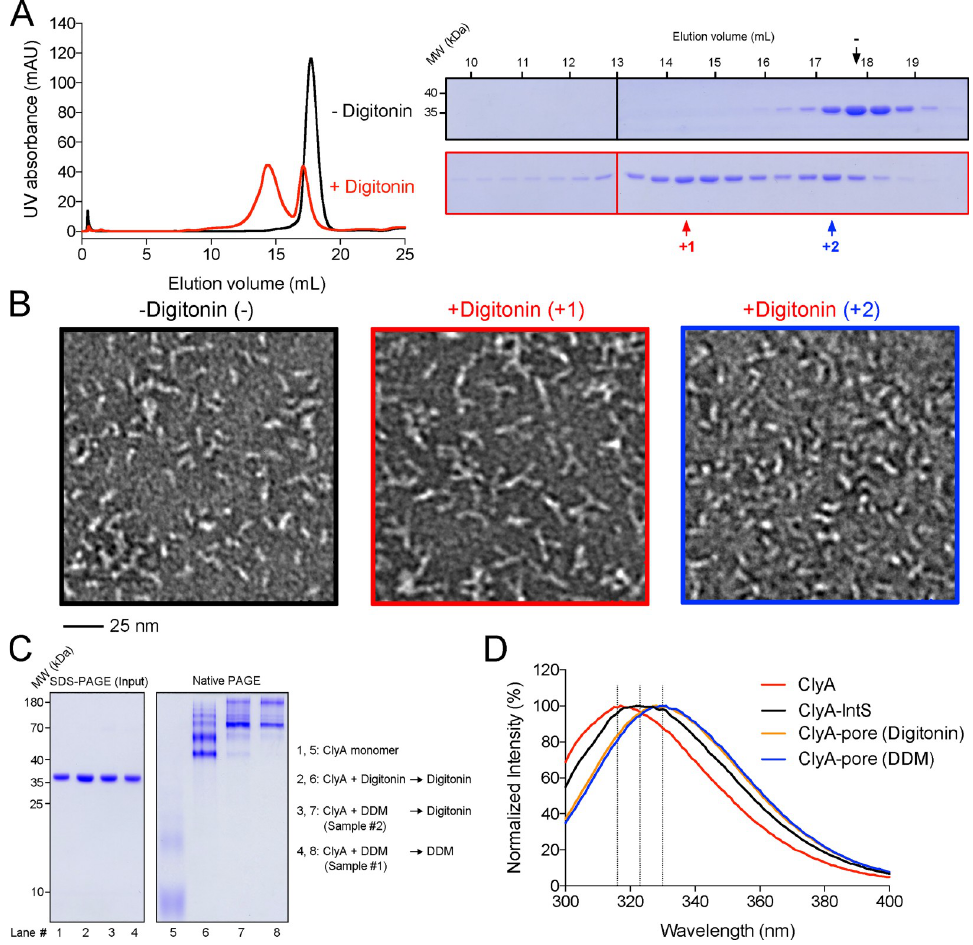
Fig 3. Characterization of a ClyA intermediate state. ( A ) SEC profile of ClyA in the soluble state and an intermediate state. Digitonin (1%) was incubated with ClyA overnight before gel filtration to obtain the intermediate state sample. The elution volumes for the two states were 17.7 mL and 14.4 mL (Superose 6 10/300 GL, GE Healthcare), respectively. ( B ) Negative staining images of ClyA in the form of soluble state and intermediate state. Fractions indicated in ( A ) were applied to negative staining (“-” indicates the soluble protein, “+1” or “+2” indicates the sample with digitonin). ( C ) Native PAGE analysis of ClyA in the soluble state (lane 1, 5), the intermediate state (lane 2, 6), and the state of mature pore complex (lane 3, 4, 7, 8). ( D ) Fluorescence emission spectra of the ClyA monomer, the intermediate state (IntS) and the pore complexes. Wavelengths of 316, 323, and 330 nm are indicated for clear visualization of peak shift.